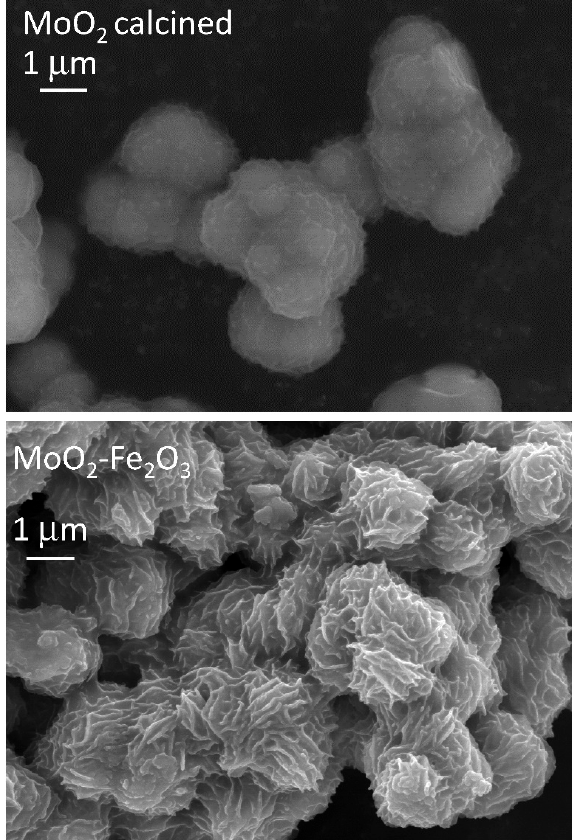
Figure 2. Scanning Electron Microscopy (SEM) images of the MoO 2 –Fe 2 O 3 and MoO 2 calcined nanoparticles (NPs). Catalysts 2020 , 10 , x FOR PEER REVIEW